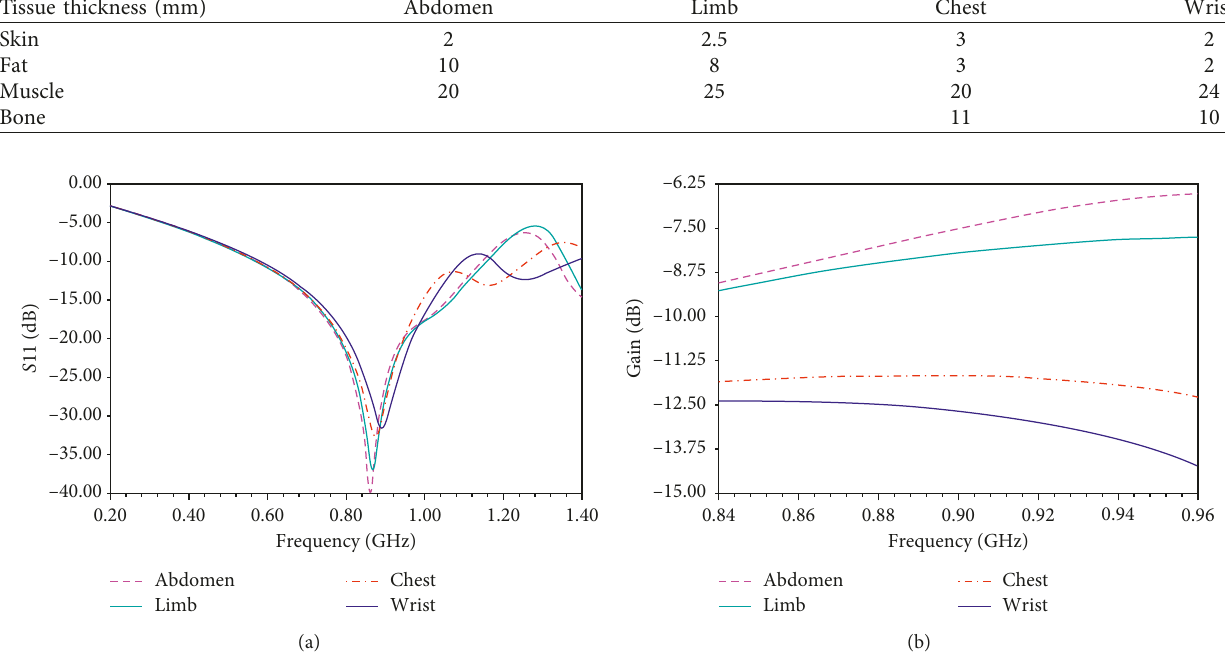
Figure 13: Simulated S 11 (a) and gain (b) of the first epidermal tag placed on some human body parts (abdomen, limb, chest, and